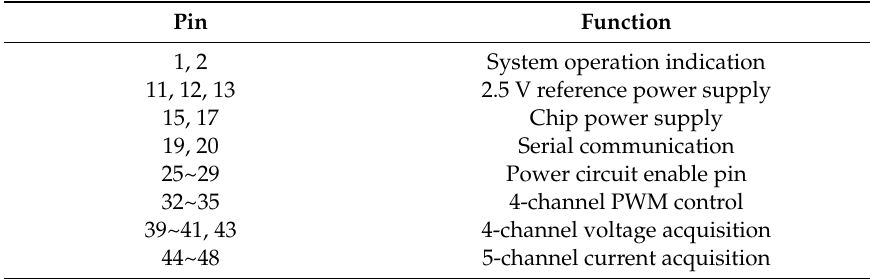
Table 1. Functional Selection of I / O